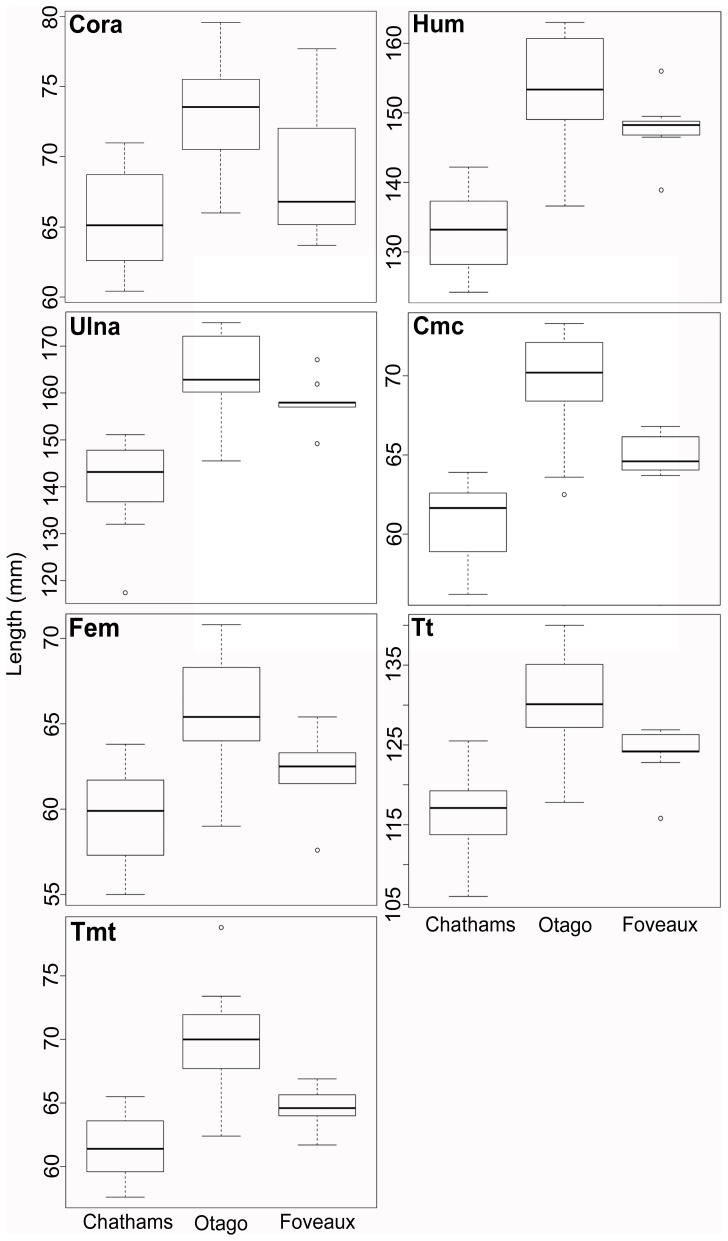
Box plots showing the distribution of Leucocarbo chalconotus and L. onslowi element lengths (mm).From the median (thick black line) outwards, are the 75th and 25th percentiles (box), the 98th and 2nd percentile (whiskers) and outliers (hollow dots). L. chalconotus from Otago are larger on average than Foveaux Strait birds (P<0.01; Table 1), and L. chalconotus are larger than L. onslowi (Table 1).